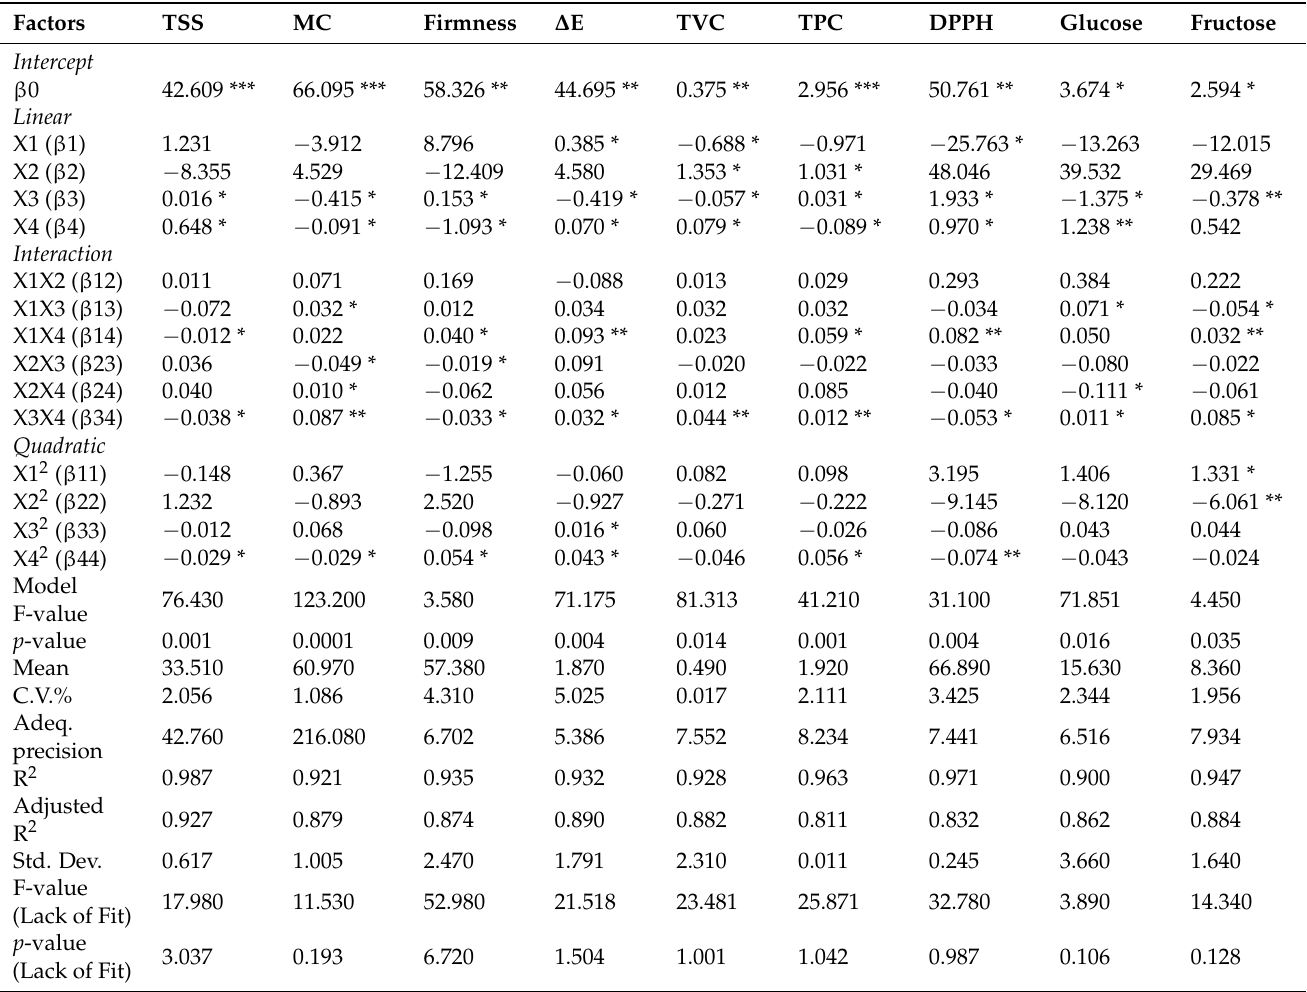
Table 1. UV Regression coefficients for process variables and product